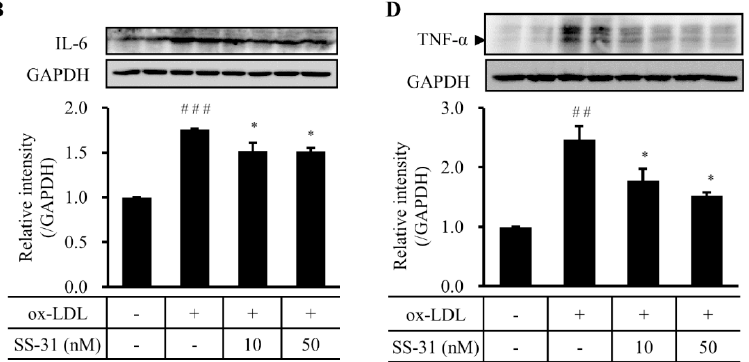
Figure 4. SS-31 inhibits ox-LDL-induced inflammation in RAW264.7 cells. ( A ) ELISA and ( B ) western blot analysis of IL-6 protein; ( C ) ELISA and ( D ) western blot analysis of TNF- α protein. A representative graph of a western blot is shown here for IL-6 and TNF- α , respectively. GAPDH was used as a loading control. The cells were treated the same as in Figure 1. All experiments were repeated four times independently. ### p < 0.001 compared with the control group, * p < 0.05 and *** p < 0.001 compared with the ox-LDL group.